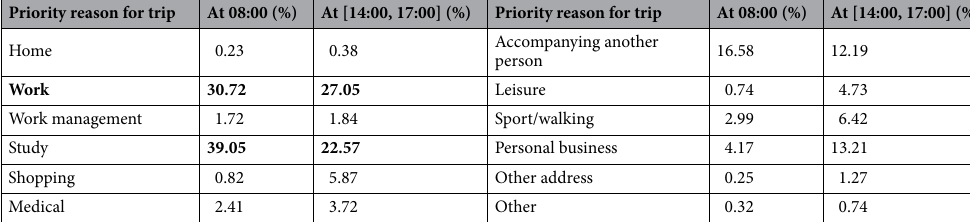
Priority reason for